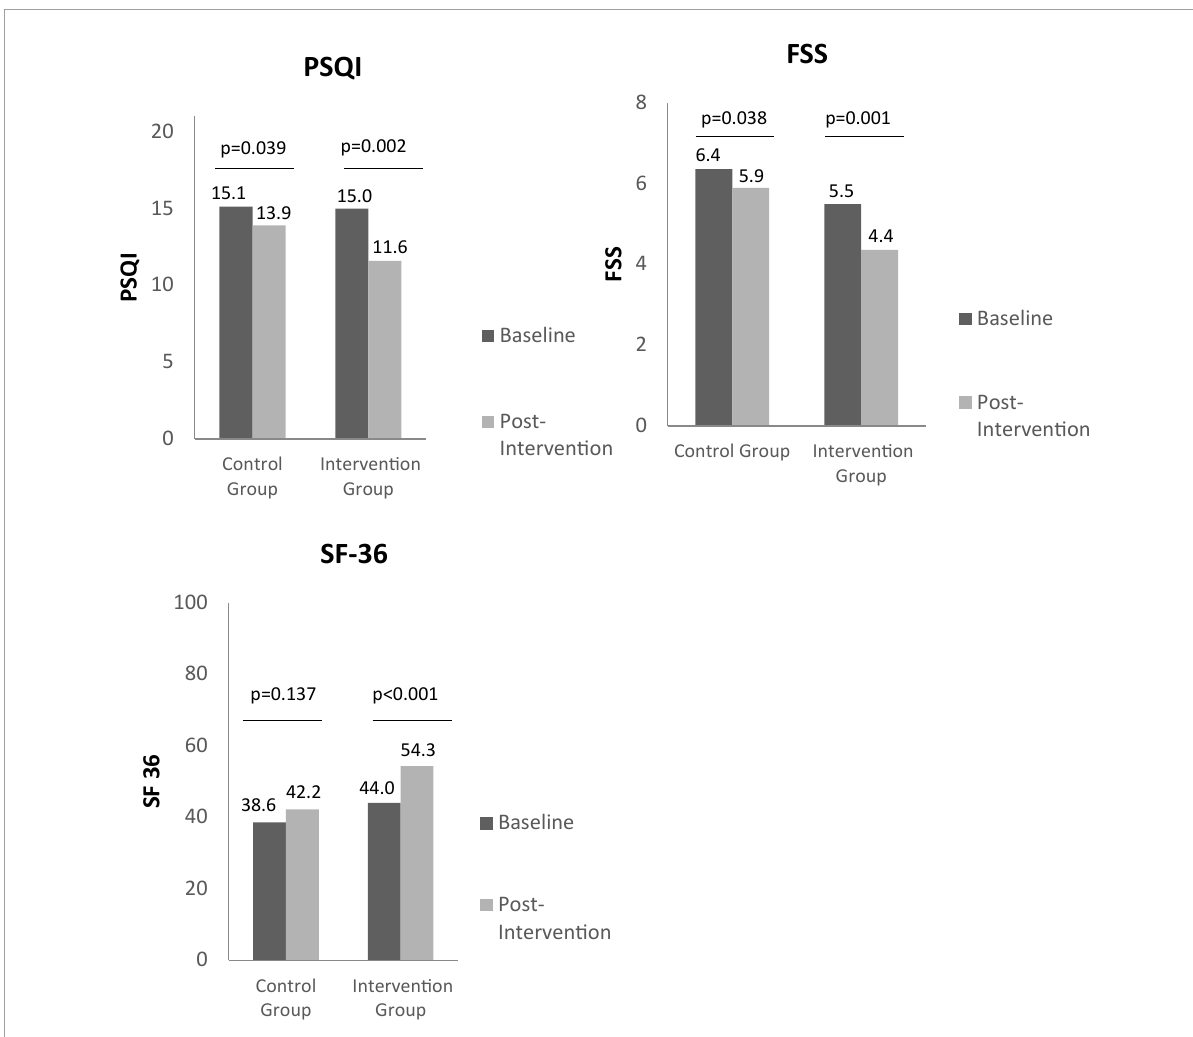
FIGURE2 Between group baseline and post intervention analysis on sleep quality, fatigue, and quality of life, through PSQI, FSS, and SF36, respectively. PSQI, Pittsburg Sleep Quality Index; FSS, Fatigue Severity Survey; SF36, Short Form